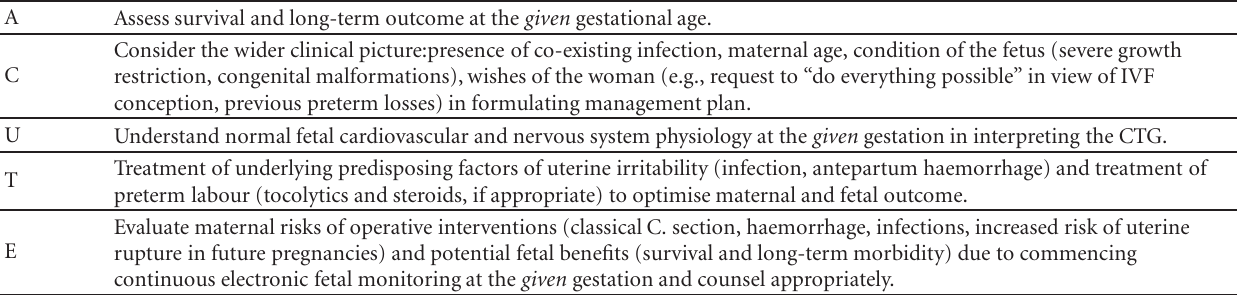
Table 3: Proposed Management Algorithm “ACUTE” for intrapartum fetal monitoring (CTG) in preterm gestations ( < 34 weeks).